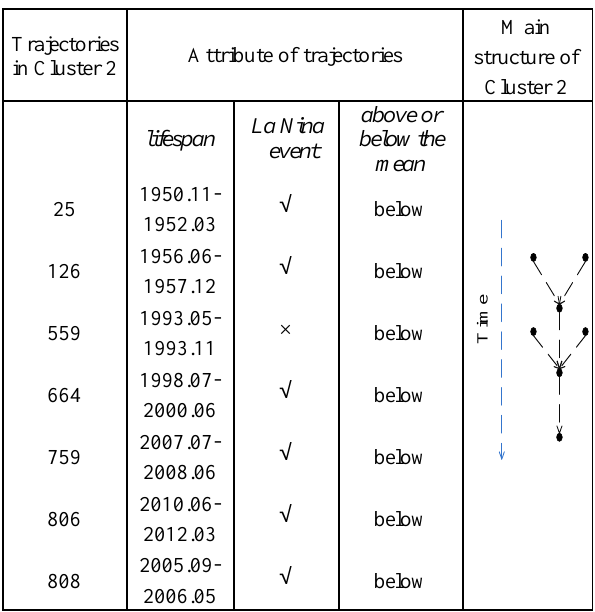
Table 2. Related information of Cluster